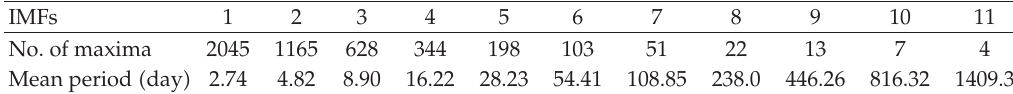
Table 3: Period statistics of daily minimum temperature